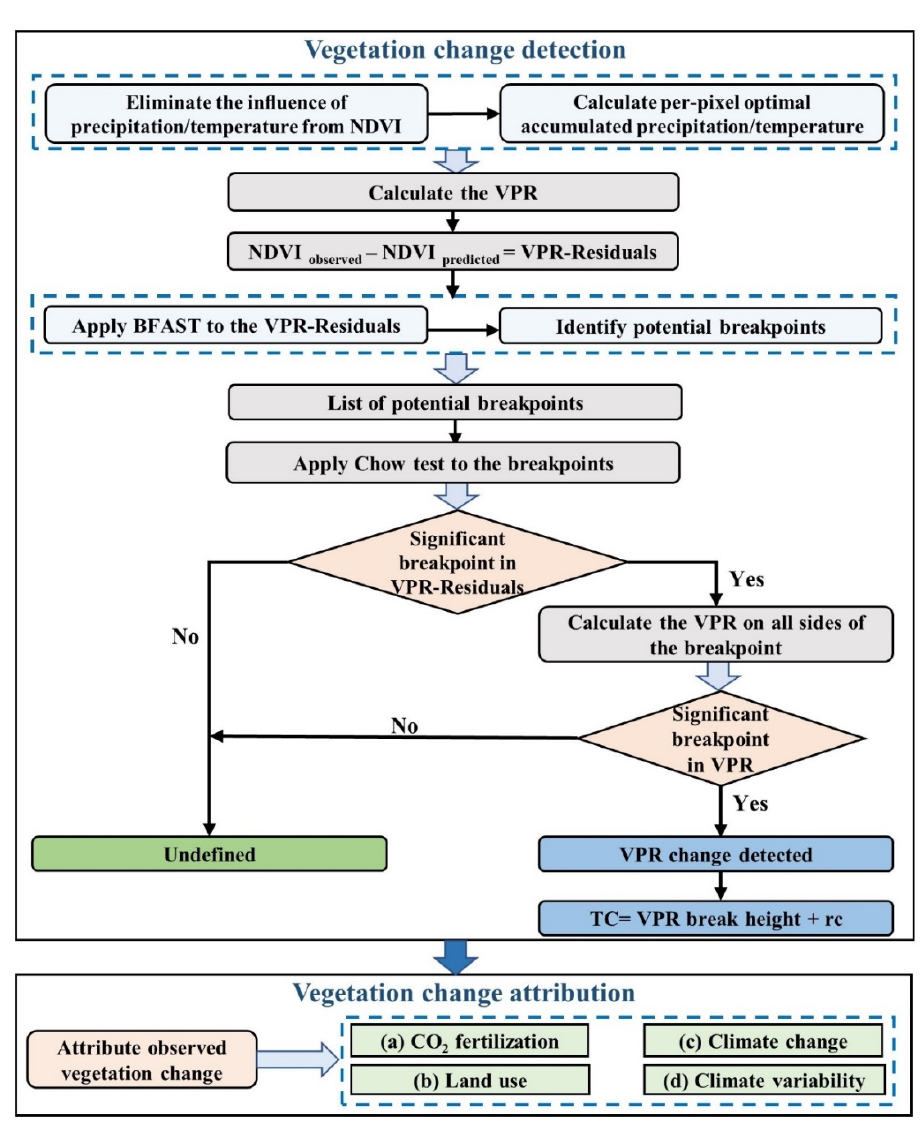
Figure 1. Flowchart of TSS-RESTREND method.